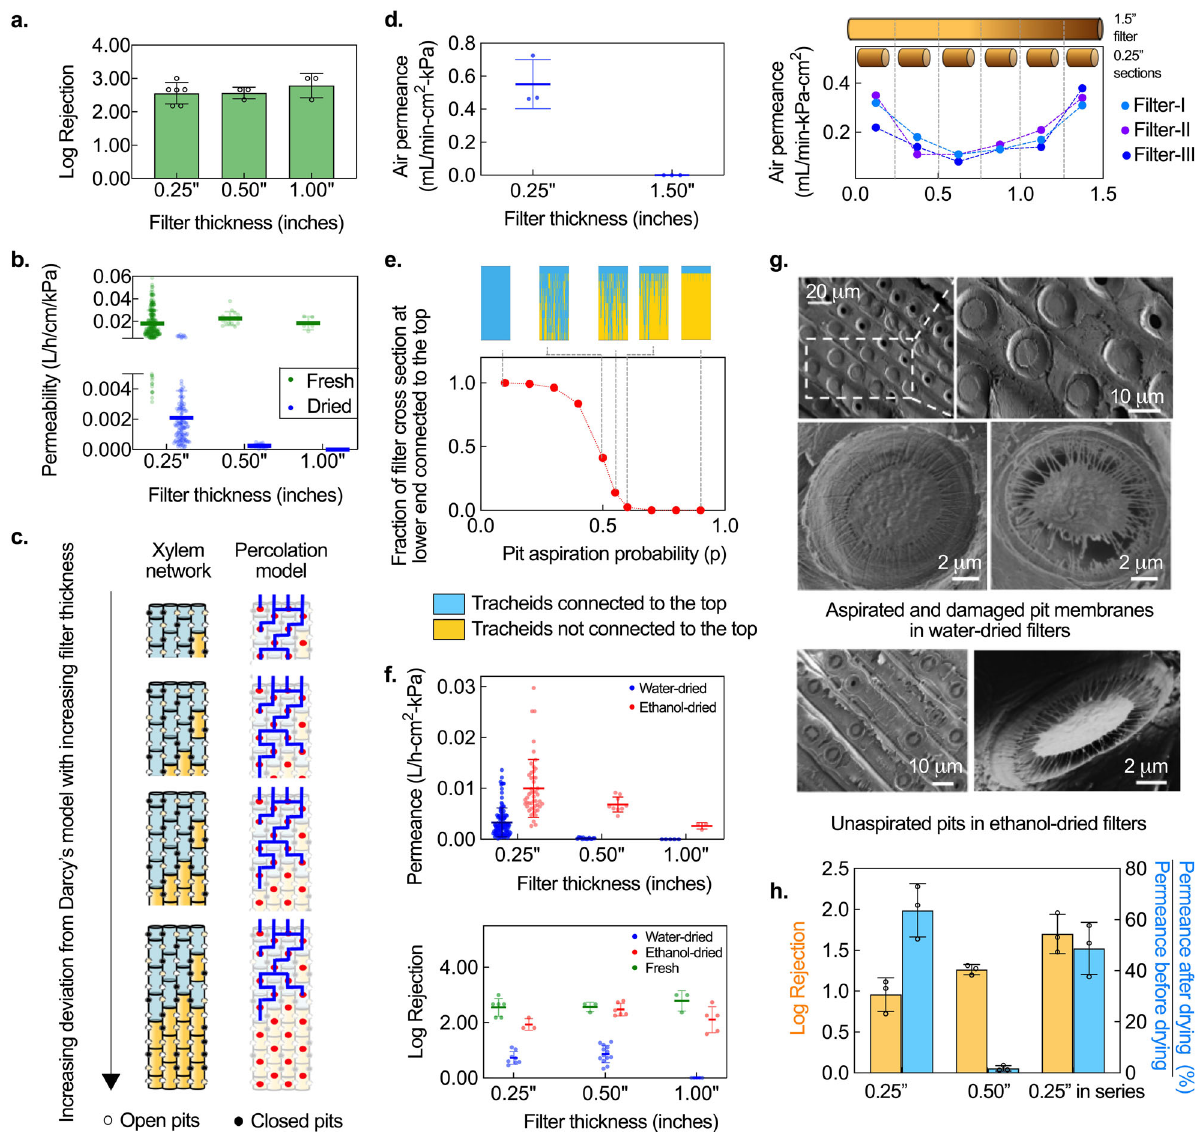
Fig. 2 Thickness-dependent permeation and dry preservation of xylem fi lters (1-cm-diameter fi lters made from Eastern white pine; rejection of 1- µ m microspheres). a Rejection of 0.25-inch-thick fresh fi lters is comparable to thicker ones. Mean ± s.d. and individual data points are shown; n = 5, 3, 3 different fi lters with 0.25-, 0.50-, and 1-inch thickness. b Permeability (permeance normalized by thickness) is constant with fi lter thickness in fresh fi lters, but drops abruptly with increasing thickness in the case of dried fi lters. Mean± s.d. and individual data points are shown; n = (280,118), (15,15), and (5,5) different fi lters (numbers denote fresh and water-dried, respectively) with 0.25-, 0.50-, and 1-inch thickness, respectively. c Schematic of the physical structure of xylem and the proposed percolation-based model (tracheids depicted as red dots) for fi lters of different thickness, illustrating percolation- governed length dependence. Black dots represent blocked tracheid connections (pit aspiration probability, p = 0.35 for all fi lters). Blue shading and lines represent tracheids and fl ow pathways that are connected to the top surface; there is no fl ow pathway from the top to bottom surface for the two thickest fi lters. d Air permeance of water-dried fi lters. 0.25-inch-thick water-dried fi lters are permeable to air whereas 1.5-inch-thick fi lters are not but 0.25-inch sections cut from 1.5-inch-thick blocked fi lters are permeable, consistent with percolation-governed permeance. Left: Individual data points and mean ± s.d. are shown; n = 3 different fi lters. Right: Each data point corresponds to a single measurement on a 0.25-inch-thick section. e Simulation results show that interconnectivity of tracheids to the top face decreases with pit aspiration probability. Inset depicts interconnected (blue) and isolated (yellow) tracheids at different pit aspiration probabilities. f Ethanol-drying reduces pit aspiration and improves permeance and rejection over water-drying in a thickness- dependent manner. Individual data points and mean ± s.d. are shown. Top: n = (118, 41), (15, 9), and (5,3) different fi lters (numbers denote water-dried and ethanol-dried, respectively) with 0.25-, 0.50-, and 1.00-inch thickness, respectively. Bottom: n = (8, 3, 6), (13, 6, 3), and (5, 5, 3) different fi lters (numbers denote water-dried, ethanol-dried, and fresh fi lters, respectively) with 0.25-, 0.50-, and 1.00-inch thickness, respectively. g SEM images reveal aspirated or damaged pit membranes in water-dried fi lters, but not in ethanol-dried fi lters. h Two 0.25-inch-thick water-dried fi lters stacked in series perform signi fi cantly better than 0.25-inch and 0.50-inch-thick water-dried fi lters. Mean ± s.d; n = 3 different fi